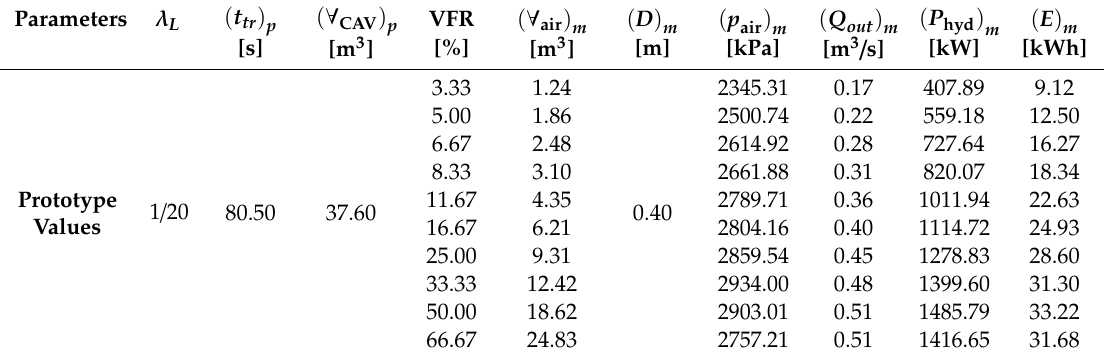
Table 5. Scaled-up parameters for a prototype with length-scale 1 / 20 and di ff erent VFRs.